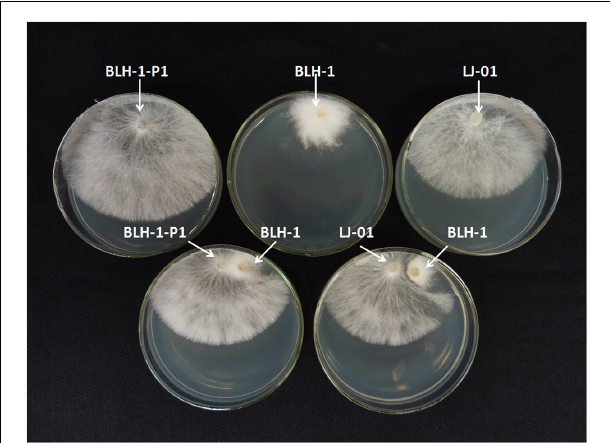
FIGURE 4 | Transmission of dsRNA elements from the hypovirulent prototype strain BLH-1 (the donor) to dsRNA-curing strain BLH-1-P1 and other wild type dsRNA- free strain LJ-01 (the recipient) on PDA using contact culture. Mycelial plugs from the BLH-1/BLH-1-P1 and BLH-1/LJ-01 combinations were individually cultured 1 cm apart on a PDA dish. Recipient derivative isolates were obtained by picking mycelial agar plugs from the edge of each colony of the two